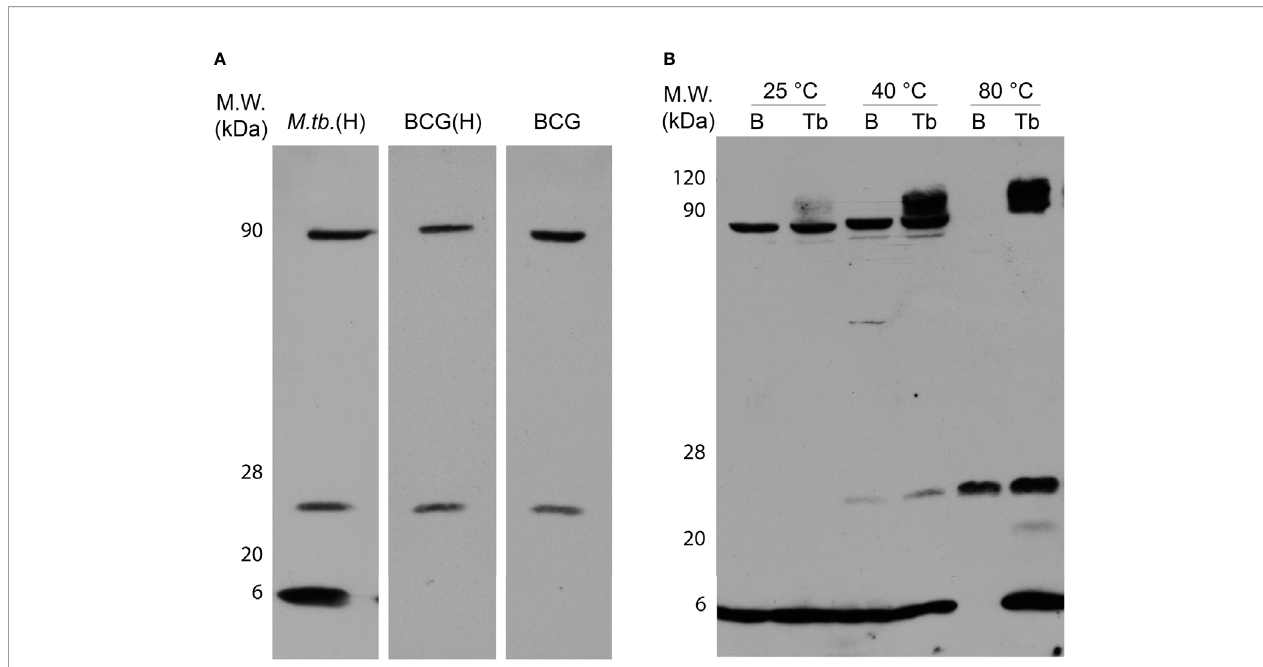
FIGURE 2 | Characterization of M.tb (Tb) and BCG Moreau (B) recombinant dodecins. Prior to western blotting, 20 µg of proteins from each sample (total proteins from IPTG-induced E.coli expressing dodecin clari fi ed lysates) were resolved on 15% SDS-PAGE. We analyzed the effect of the loss of the seven N-terminal amino acids on dodecin (A) dodecamerization capacity and (B) thermostability. E. coli expressing the BCG Moreau dodecin lacking the 6-His tag was included ( A ; BCG). For thermostability assays, protein samples were incubated for 30 min in each condition tested, prior to sample clari fi cation by centrifugation and analysis of supernatant by SDS-PAGE and western blotting. Results are representatives of a set of three independent